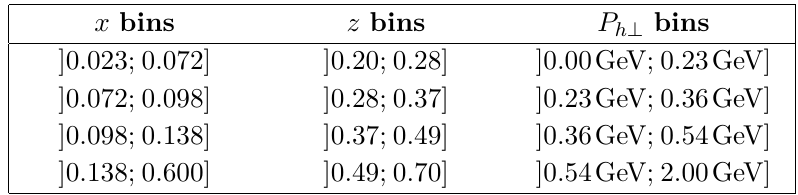
Table 5 . Definition of the three-dimensional binning for charged mesons: the first, second, and third columns list the limits in the kinematic variables x , z , and P h ⊥ , respectively.